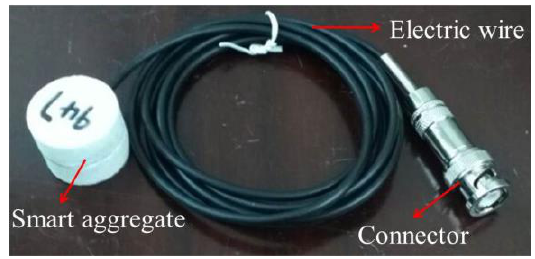
Figure 1. A smart aggregate (SA).